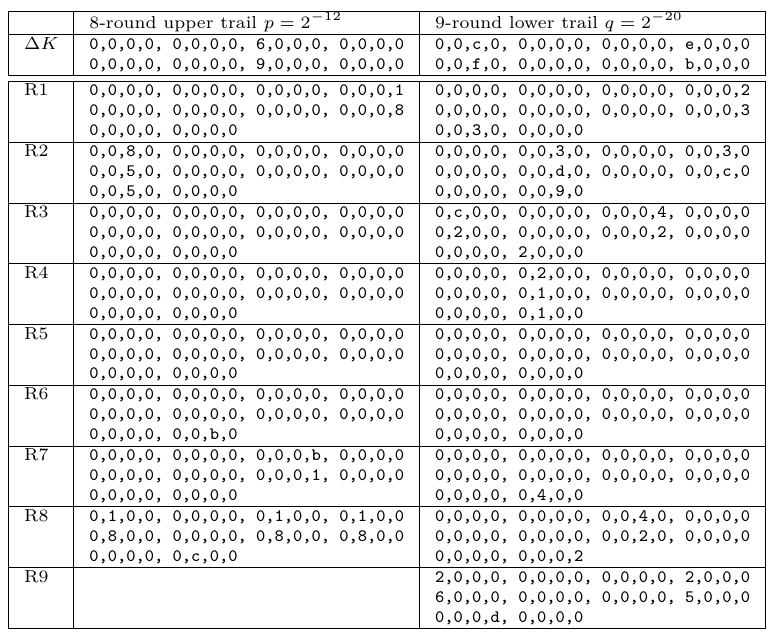
Table 12: Trails for